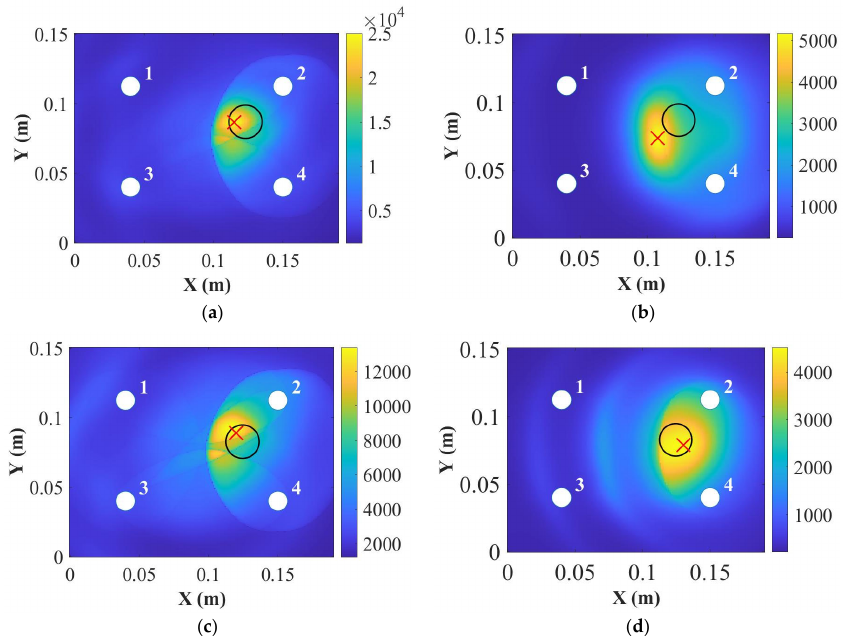
Figure 12. Damage localisations for the 9 mm thick panel at 50 kHz ( a ) and 250 kHz ( b ) for the opposite side of the Blu Tack and at 50 kHz ( c ) and 250 kHz ( d ) for the same side of the Blu Tack (where “ ○ ” is the position for real damage and “ × ” is the position for predicted damage).